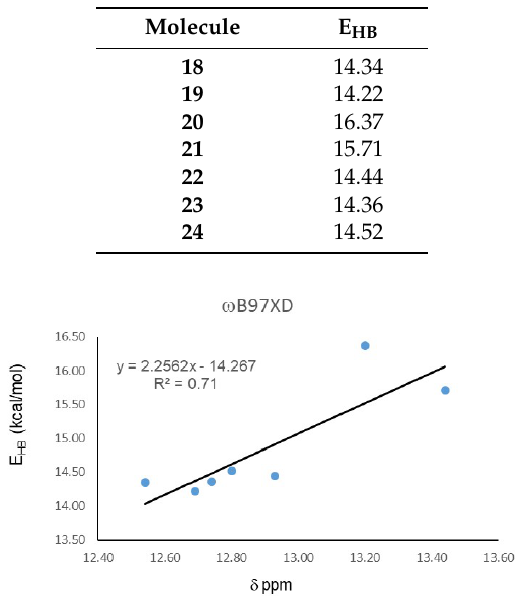
Table 2. Hydrogen bond energy (E HB ), calculated as the difference between open and close conformers. Energies in kcal/mol.